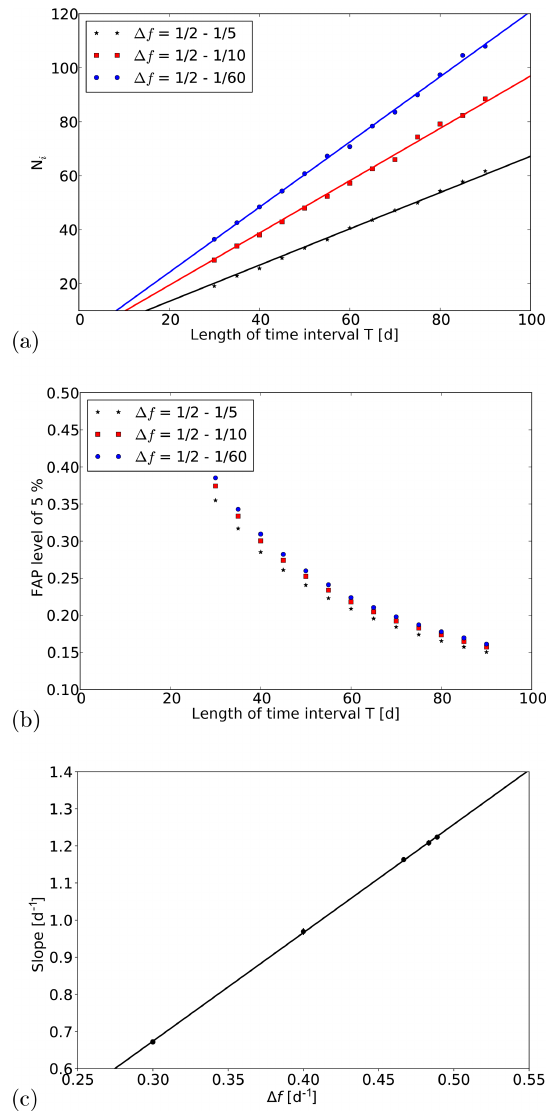
Figure 3. (a, b) Dependency of N i and the FAP level of 5% on the length of the time interval T and the frequency range. The analysed frequency ranges are 1 / 2–1 / 5, 1 / 2–1 / 10, and 1 / 2–1 / 60d − 1 , and the time series of the simulations have no data gaps. (c) Dependency of the slopes (lines from panel a ) and additionally for the frequency ranges (1 / 2–1 / 30 and 1 / 2–1 / 90d − 1 ) on the frequency range (cid:49)f . The error bars show 2 times the standard error of the